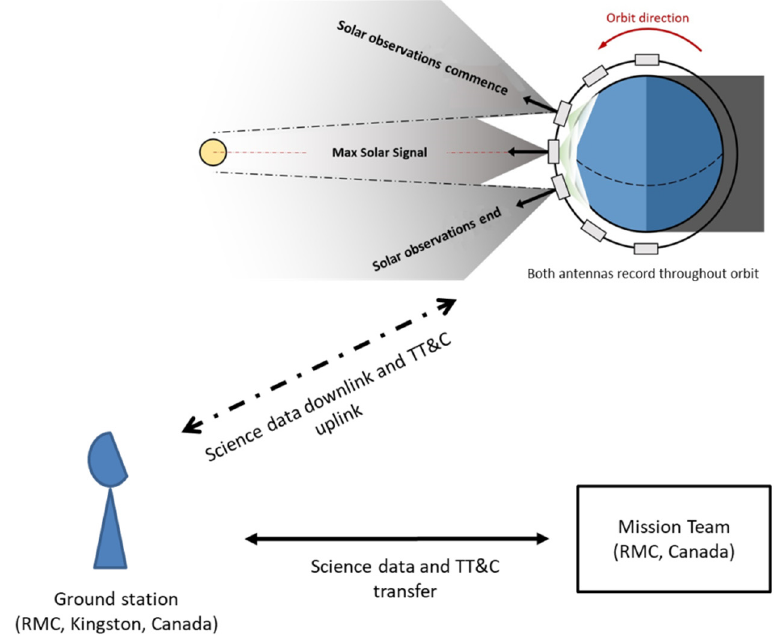
Figure 8. Concept diagram of RMCSat mission.